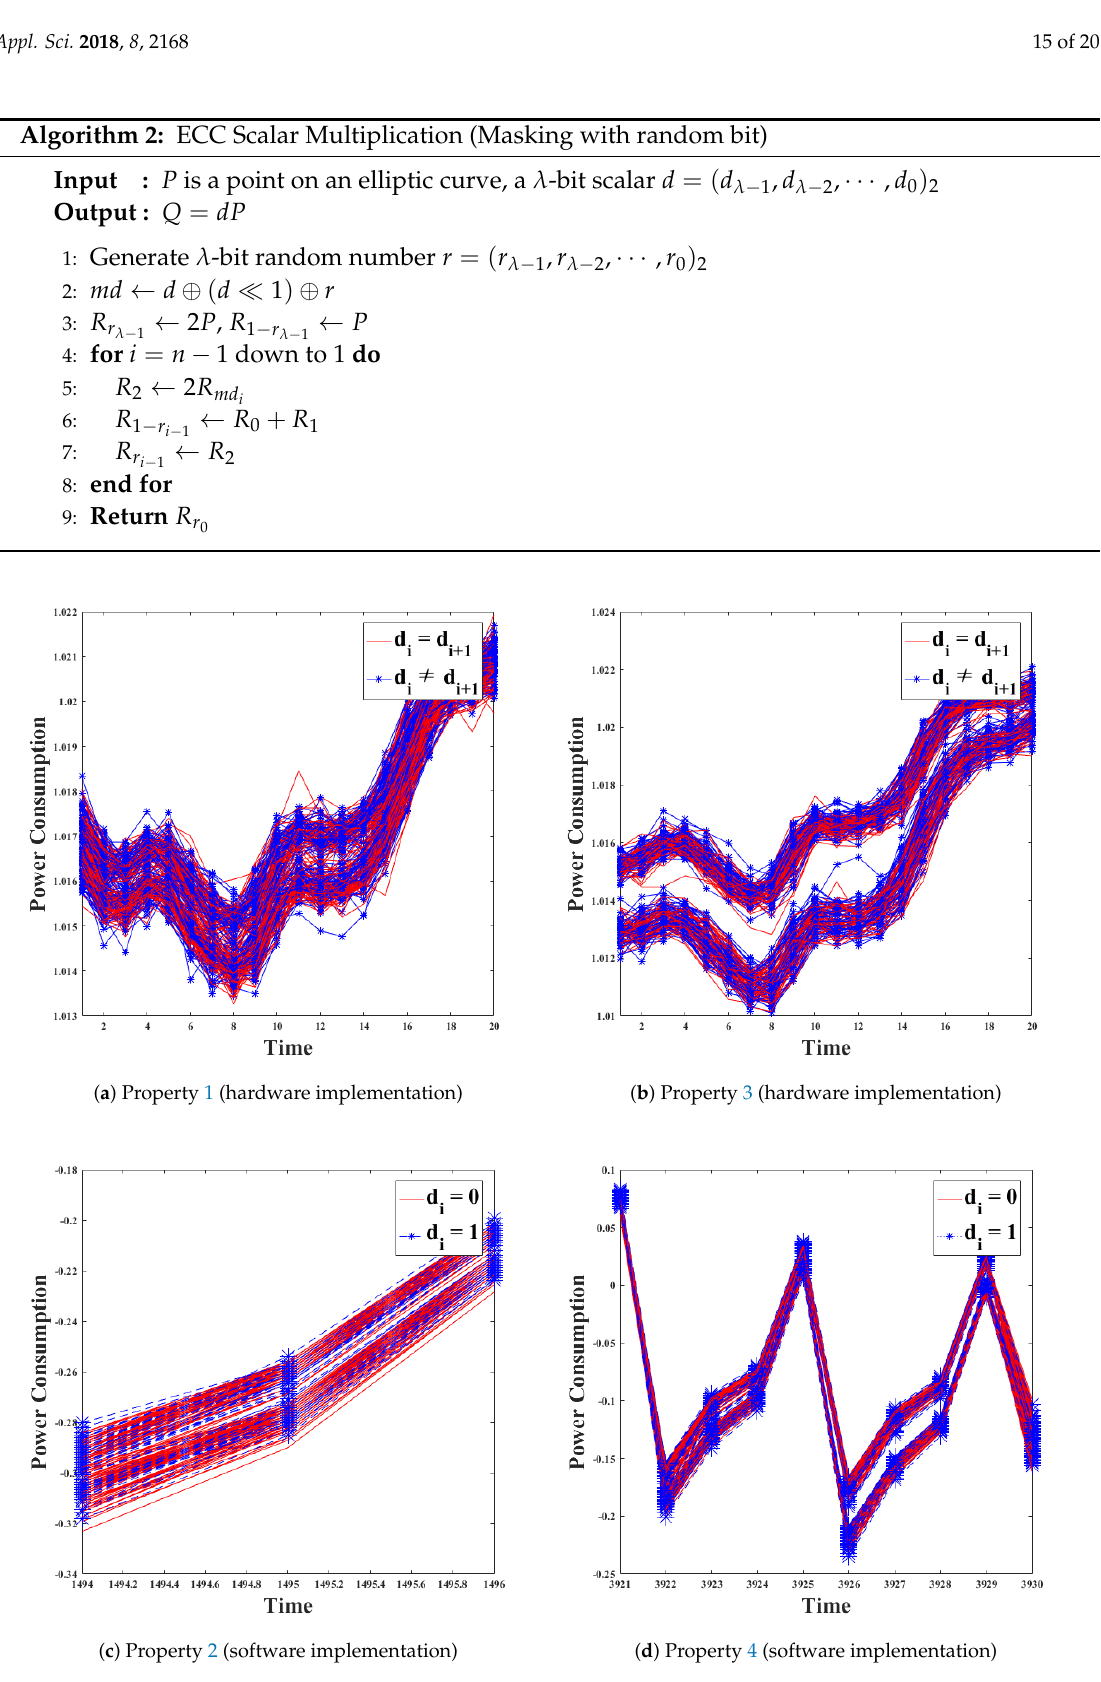
Figure 13. Countermeasure (Power). ( a ) Property 1 (hardware implementation); ( b ) Property 3 (hardware implementation); ( c ) Property 2 (software implementation); ( d ) Property 4 (software